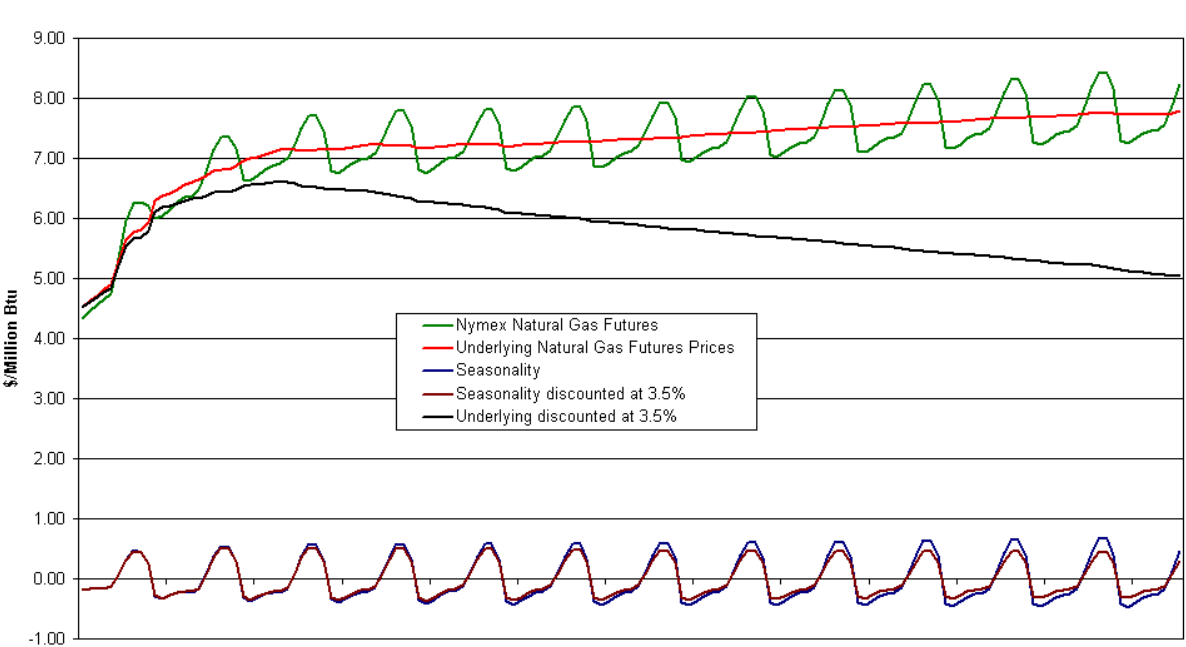
Figure 1. Futures prices of natural gas on NYMEX